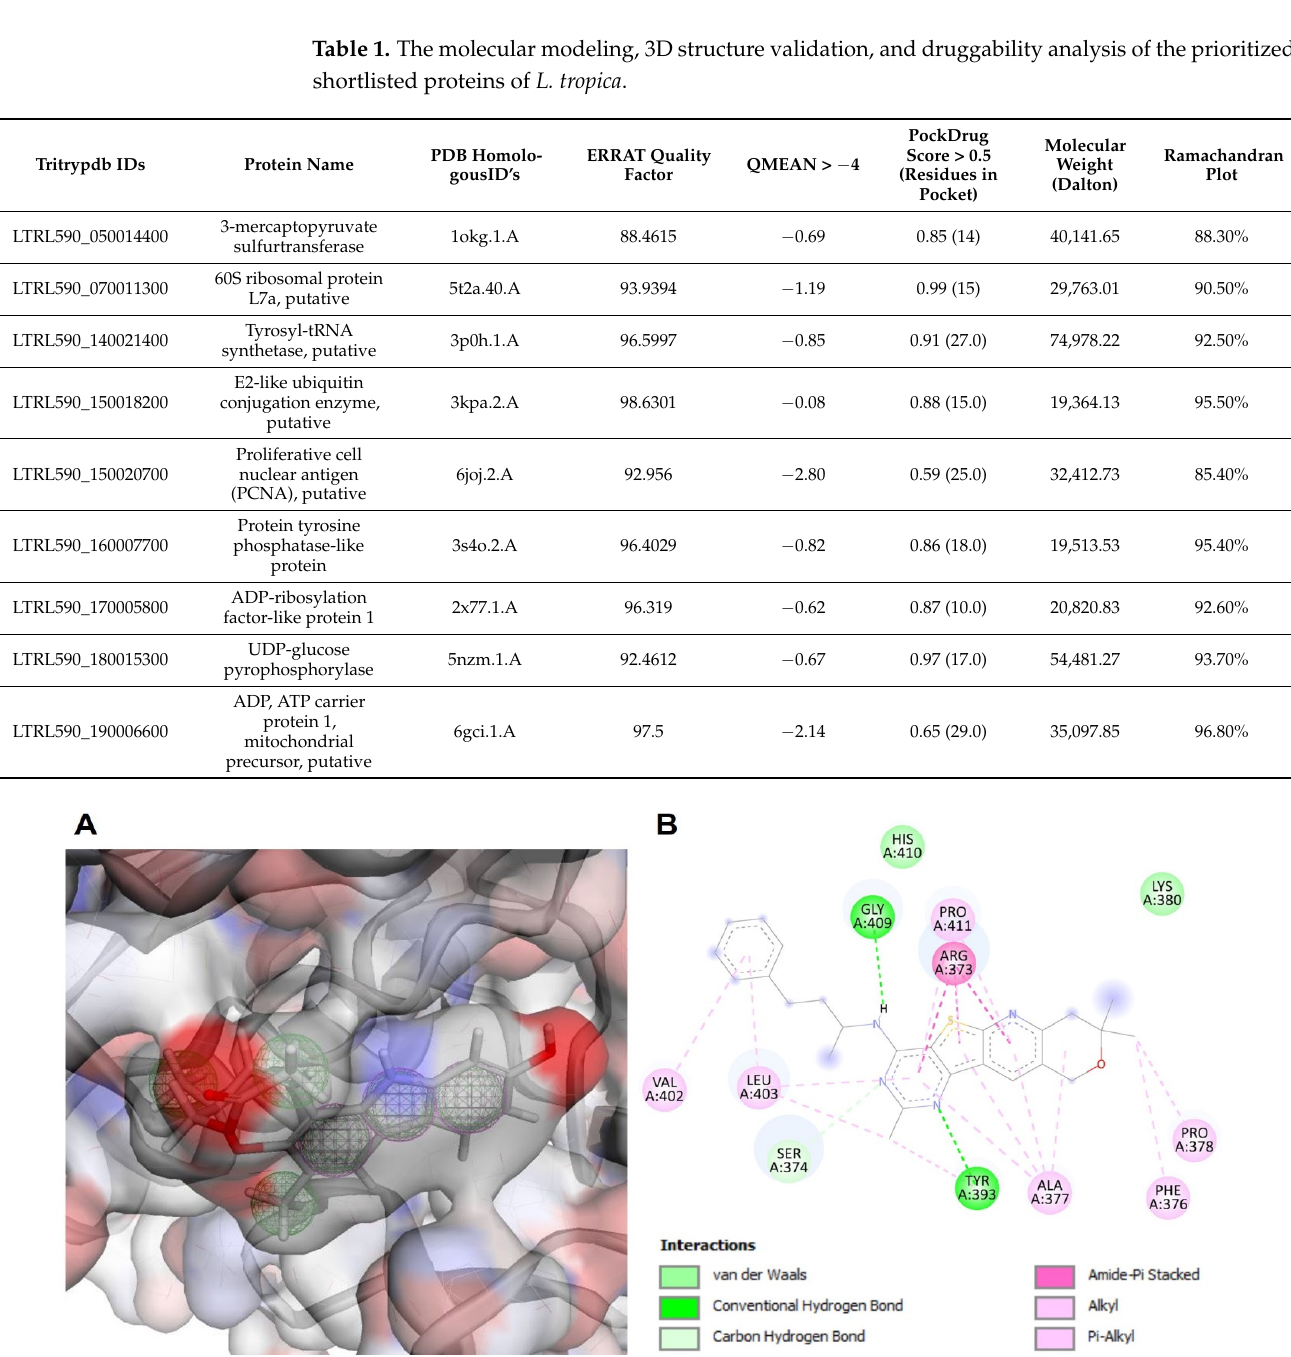
Figure 3. ( A ) The pharmacophore design based on the active site of LtUGPase. ( B ) The molecular interaction of top hit compound docked in the active site of LtUGPase. The nature of protein–ligand interactions is represented with different colors. Table 2. CB-Dock scores and RMSD values of top 10 hit molecules obtained against UGPase target from virtual screening using Pharmit server .